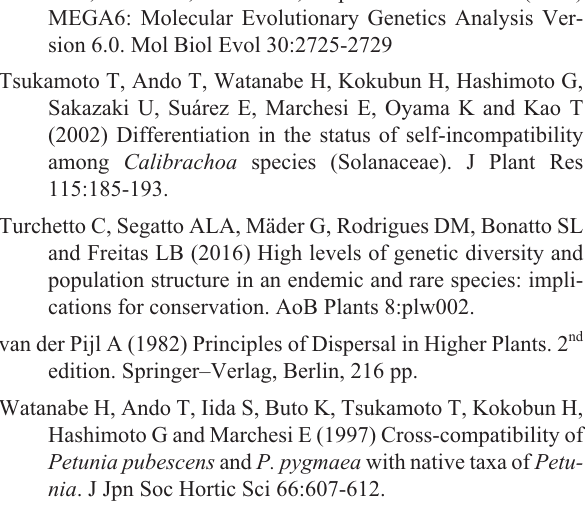
Calibrachoa species Figure S1 - Calibrachoa eglandulata. Figure S2 - Calibrachoa sendtneriana . Figure S3 - Calibrachoa serrulata. Figure S4 - Calibrachoa spathulata. Figure S5 - Bayesian skyline plot showing the fluctuations in effective population size (Ne) over time per Calibrachoa species. Figure S6 - Population structure and evolutionary relation- ships of individuals of four Calibrachoa species based on five microsatellite